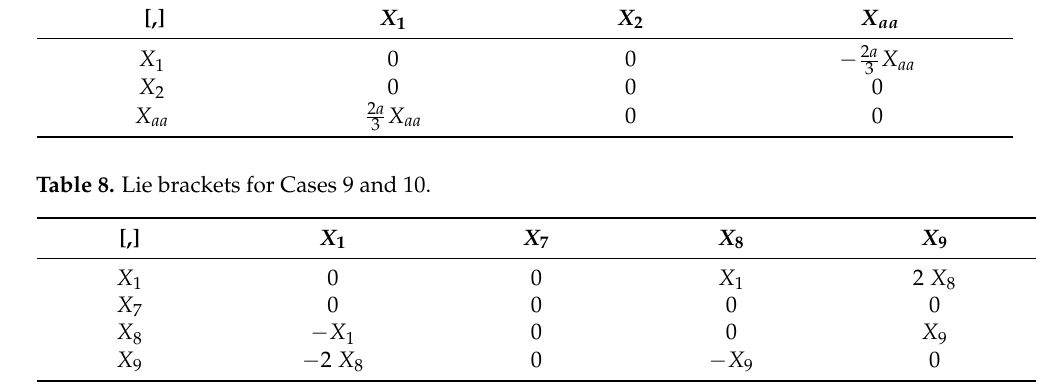
Table 7. Lie brackets for Case 7.